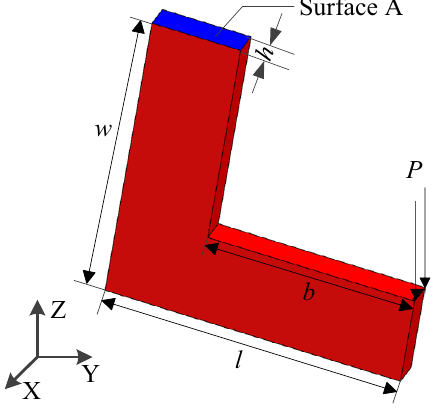
Figure 4. L-shaped bracket structure